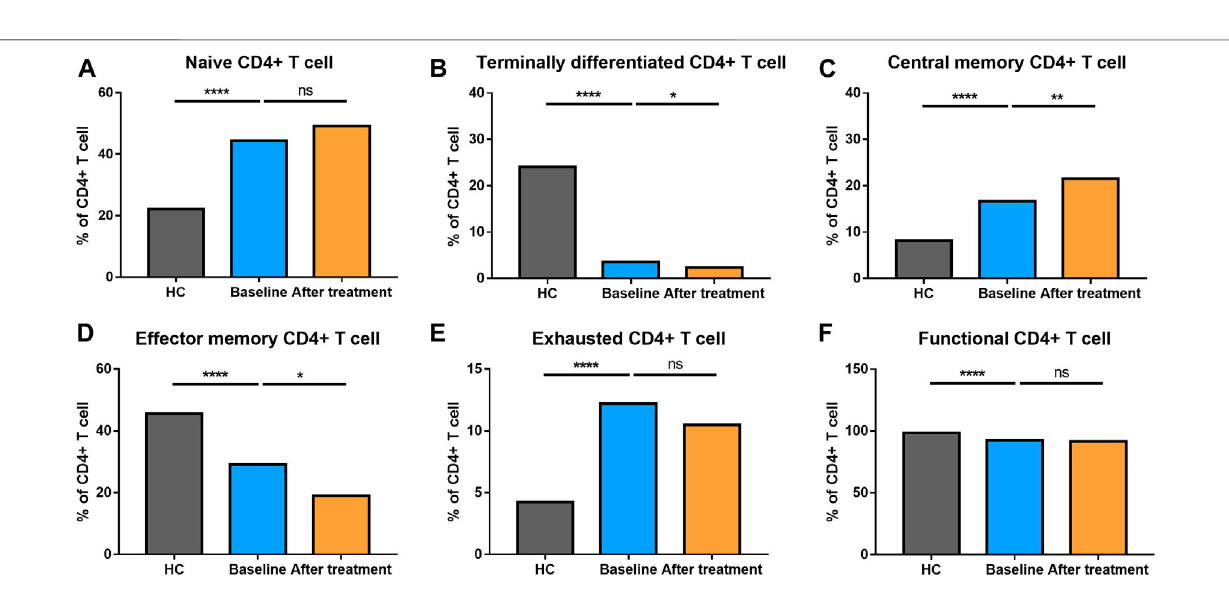
( Figure 1 ). AS patients had a lower proportion of total T cells, CD4/CD8 ratio, and double-positive (DP) T cells ( Figure 2 ). In CD4 + T cell subsets, the proportions of naïve CD4 + T cells, central memory CD4 + T cells and exhausted CD4 + T cells became signi fi cantly increased, but the levels of terminally differentiated CD4 + T cells, together with effector memory CD4 + T cells, were reduced signi fi cantly in AS ( Figure 3 ). The proportion of CD8 + T cells at different stages of differentiation was also determined ( Figure 4 ). AS patients